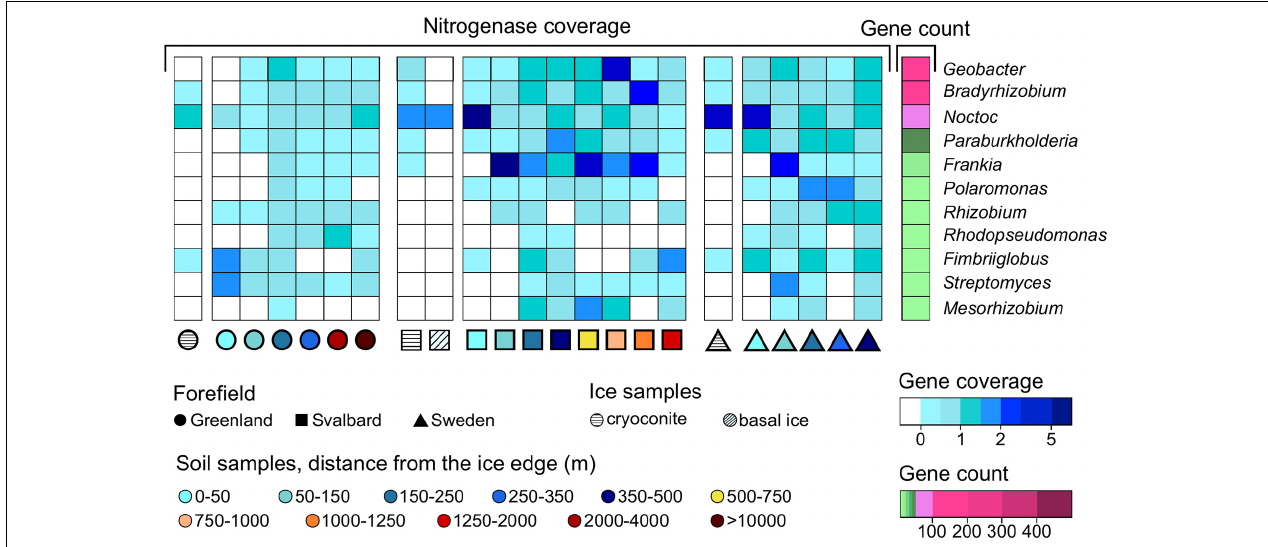
FIGURE 7 | Nitrogenase gene trends at the genus level along the microbial succession. Only genera with more than one coding region associated with a nitrogenase are reported.